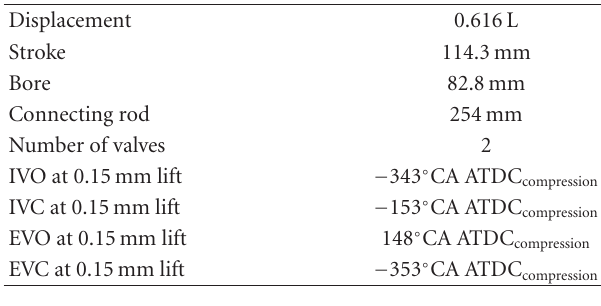
Table 1: Engine specifications.